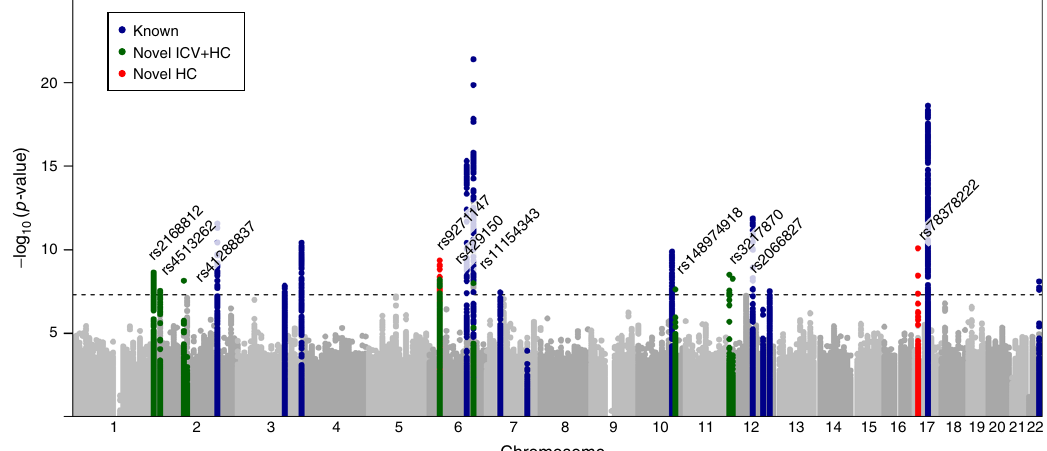
Fig. 6 Genome-wide association analysis of fi nal cranial dimension. A genome-wide weighted Z -score meta-analysis of combined head circumference (HC) and intracranial volume (ICV) was carried out (ICV + HC (Pediatric + adult): N = 45,458). The dashed line represents the threshold for nominal genome-wide ( p < 5.0×10 − 8 ) signi fi cance. Accounting for multiple testing, the adjusted level of genome-wide signi fi cance is p <3.3×10 − 8 . Known variants for ICV, brain volume, and HC are shown in blue. Novel signals passing a nominal genome-wide association threshold ( p <5.0×10 − 8 ) are shown with their lead SNP in green (Table 2, Table S15). HC (Pediatric + adult) signals identi fi ed in this study are shown in red. The genomic position is shown according to NCBI Build 37